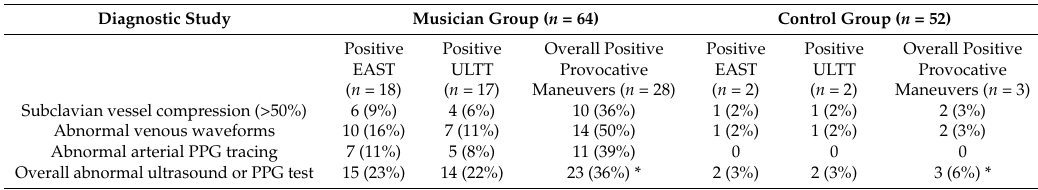
Table 5. Assessment of positive provocative maneuvers with the presence of abnormal ultrasound or PPG